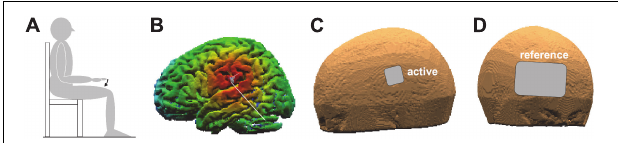
FIGURE 1 | (A) Position of the experimental subject. The arrow indicates index-finger flexion with the preferred hand prone. (B) False-color map of the distance between the tip of the neuronavigator pointing stylus, positioned on the scalp, and the reconstructed brain surface. The white line points to the coPO, identified by means of its Talairach coordinates. (C,D) Position of the active and reference electrodes (3.16 × 3.16 cm and 8 × 12 cm,